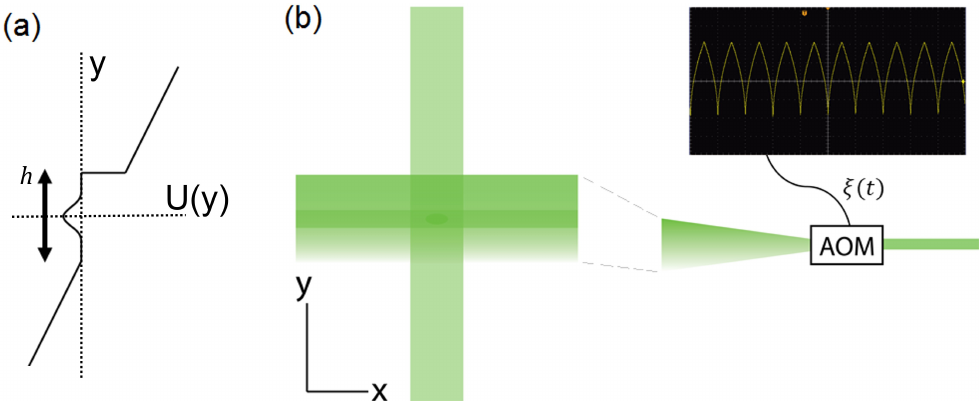
Figure 2. Implementation of a shaped optical beam for gravity compensation. ( a ) model for total optical potential along the vertical axis, through the center of the optical trapping region; ( b ) illustration of the ODT geometry along with the shaped optical beam. This beam is used to compensate the linear gravitational potential through use of an acousto-optic modulator supplied with the waveform, ξ ( t ) , as